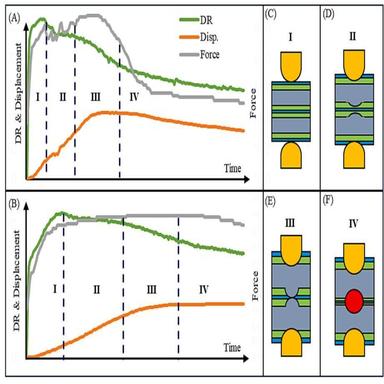
The proposed 4-Phase IDL-inclusive model: (A) 4 phases for welding with IDL, (B) 4 phases for welding without IDL, (C)-(F): illustration of welding process during corresponding phases.